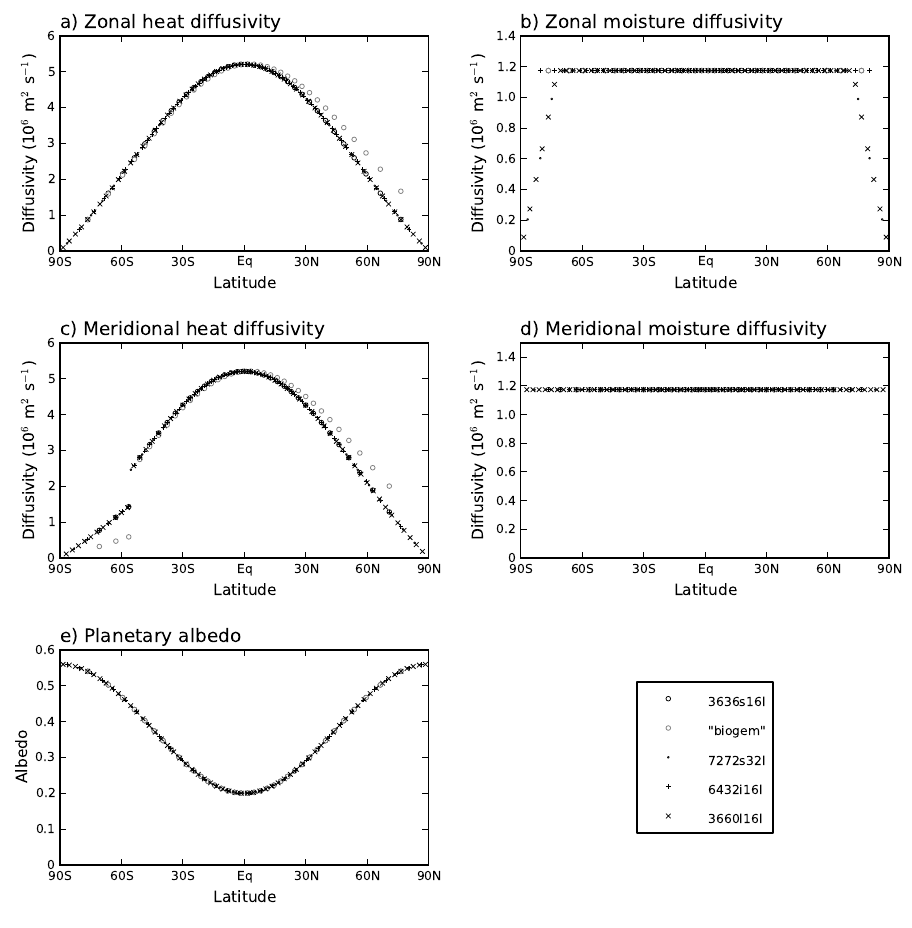
Fig. 5. Meridional profiles of zonal (a, b) and meridional (c, d) heat (a, c) and moisture (b, d) diffusivity coefficients, as well as of planetary albedo (e) , for each